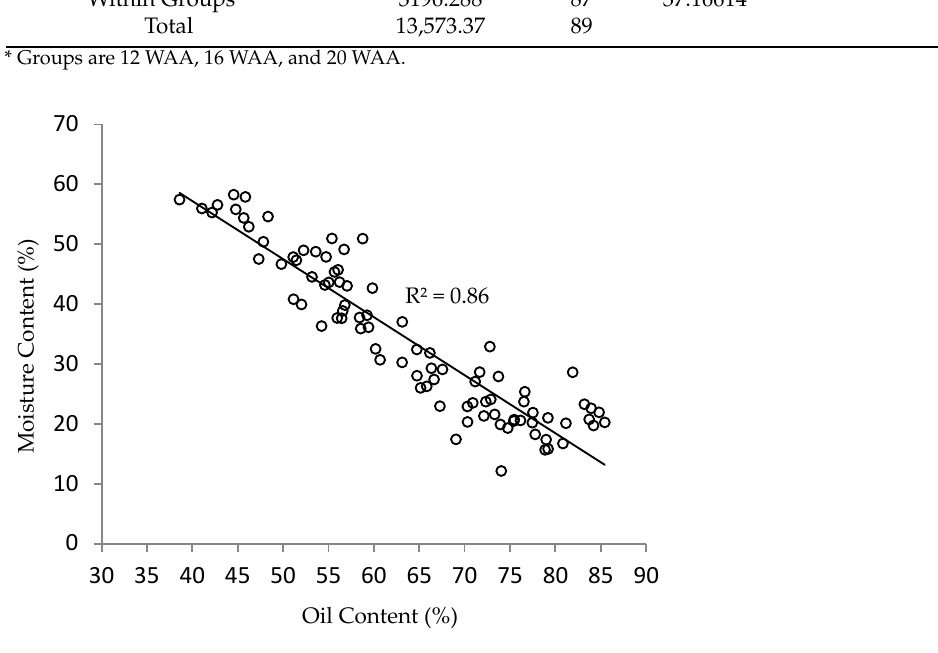
Figure 2. Relationship between oil and moisture content of oil palm fruitlets measured at 12, 16, and 20 WAA.